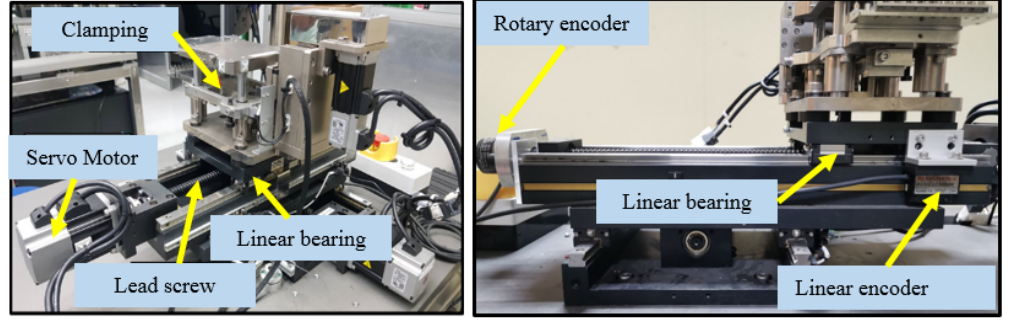
Figure 15. XY stage actuator.